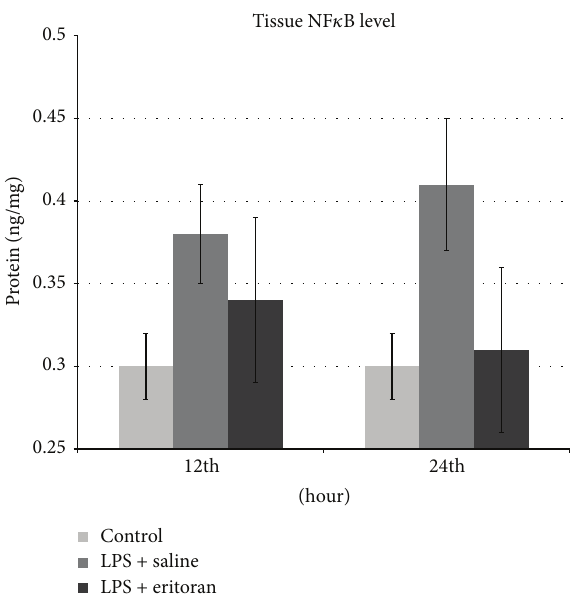
Figure 5: The nuclear factor kappa B (Nf 𝜅 B) levels in retino- choroidal tissue after 12h and 24h in control group with no intervention, rats with sepsis but without eritoran, and rats with sepsis treated with eritoran. Vertical lines show standard deviation. LPS: